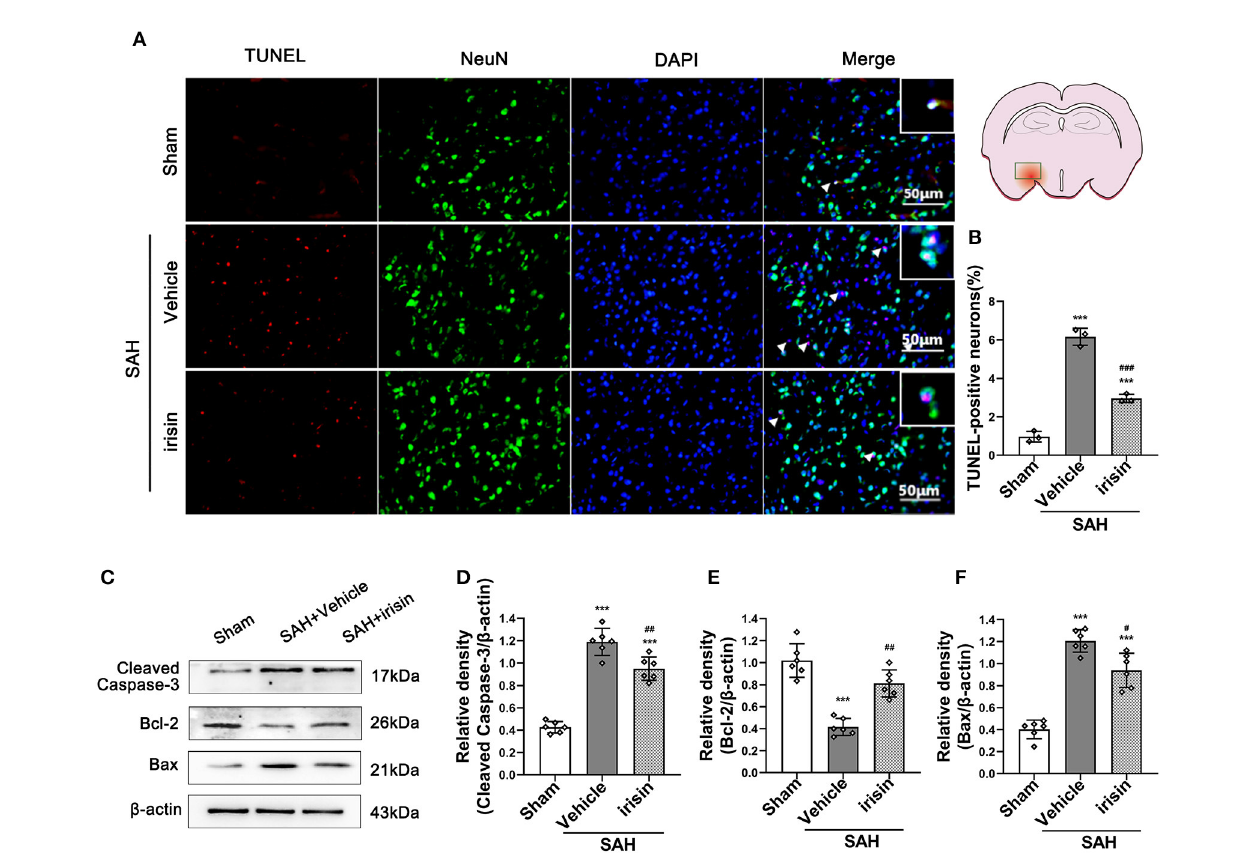
FIGURE 4 | Anti-apoptosis effects of exogenous irisin treatment on neurons 24h after SAH. (A,B) TUNEL-positive neurons were significantly decreased after exogenous irisin administration. Scale bar = 50 µ m, n = 3 for each group. (C–F) Representative western blotting images and relative density analysis of Bax, Bcl-2, and cleaved caspase-3 at 24h after SAH. Exogenous irisin treatment significantly improved the expressions of Bcl-2 (E) and result in a decreased level of apoptotic marker cleaved caspase-3 (D) and Bax (F) , n = 6 for each group. Data were presented as mean ± SD. The one-way ANOVA was used followed by the Tukey’s HSD post-hoc test and the Holm–Bonferroni correction method. *** P < 0.001 vs. Sham group; # P < 0.05, ## P < 0.01, ### P < 0.001 vs. SAH + Vehicle group. Vehicle group, sterile 0.9% of NaCl; TUNEL, TdT-UTP nick end